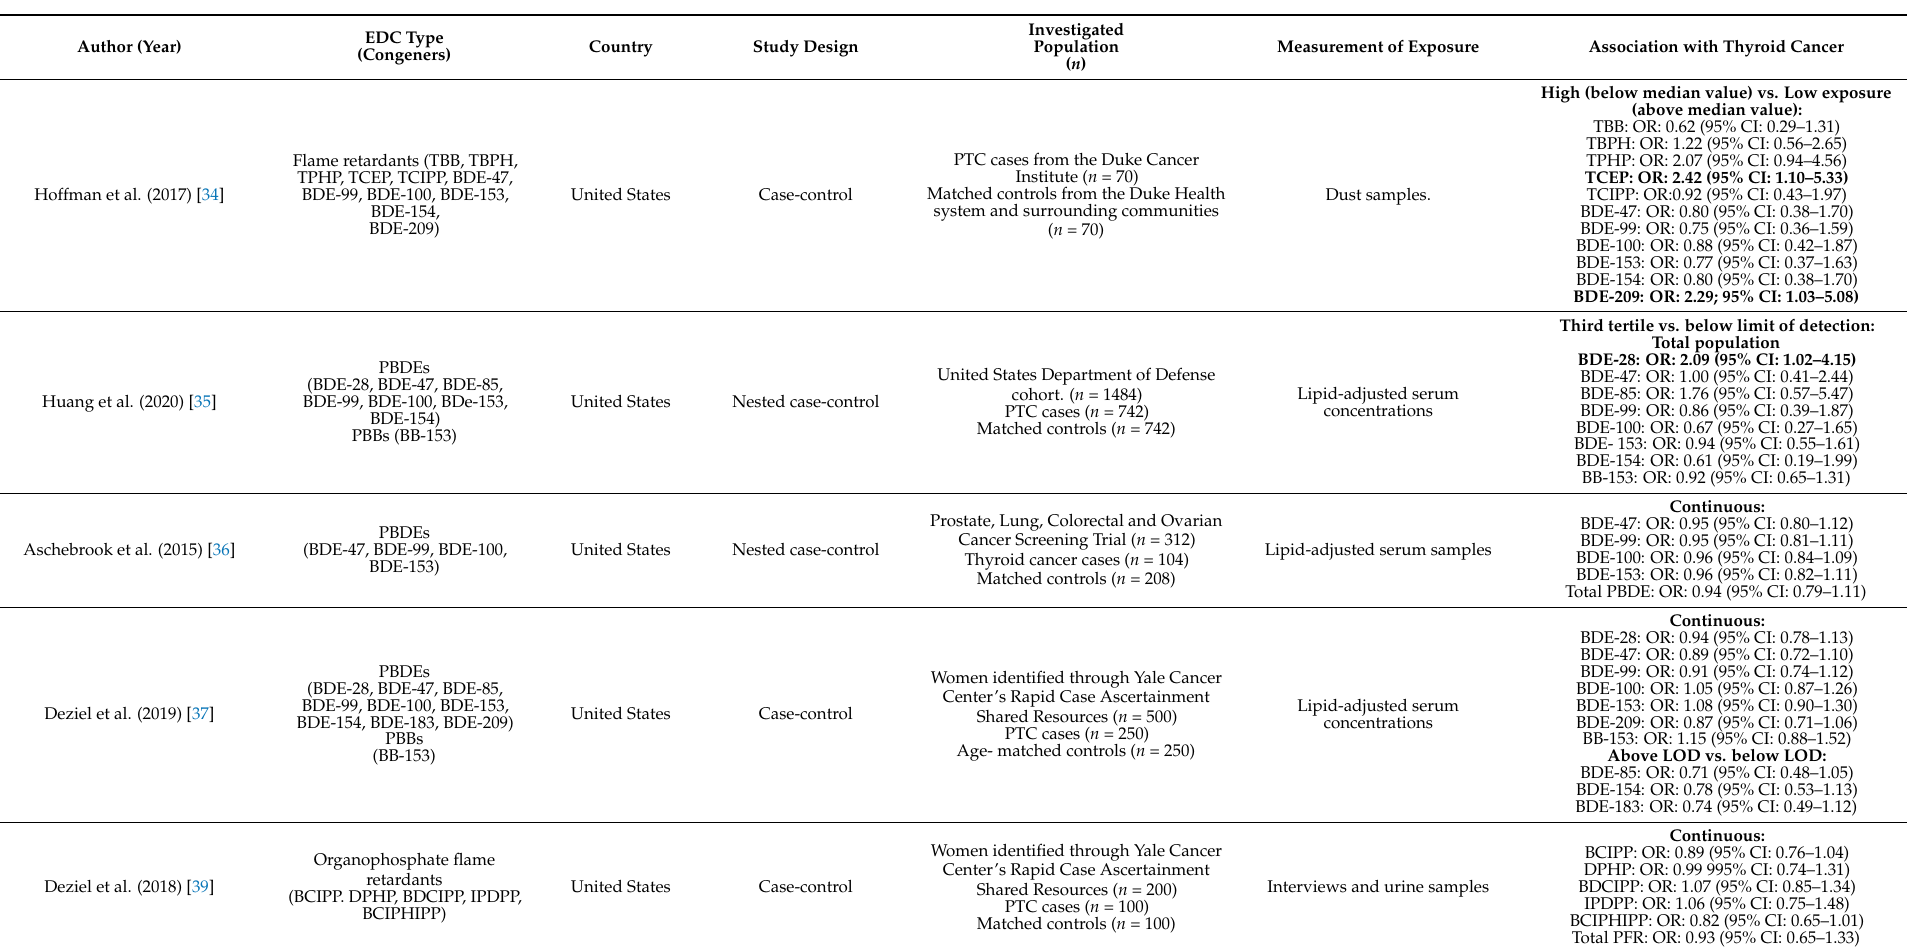
Table 1. Association between exposure to flame retardants and thyroid cancer. Abbreviations: BB: brominated biphenyl; BCIPHIPP: 1-hydroxy-2-propyl bis(1-chloro-2-propyl) phosphate; BCIPP: bis(1,3-dichloro-2-propyl) phosphate; BDCIPP: bis(1,3-dichloro-2-propyl) phosphate; BDE: brominated diphenyl ethers; CI: confidence interval; DPHP: diphenyl phosphate; EDC: endocrine disrupting chemicals; IPDPP: isopropylated triphenyl phosphate; OR: Odd ratio; PBB: polybrominated biphenyl; PBDE: polybrominated diphenyl ethers; PFR: